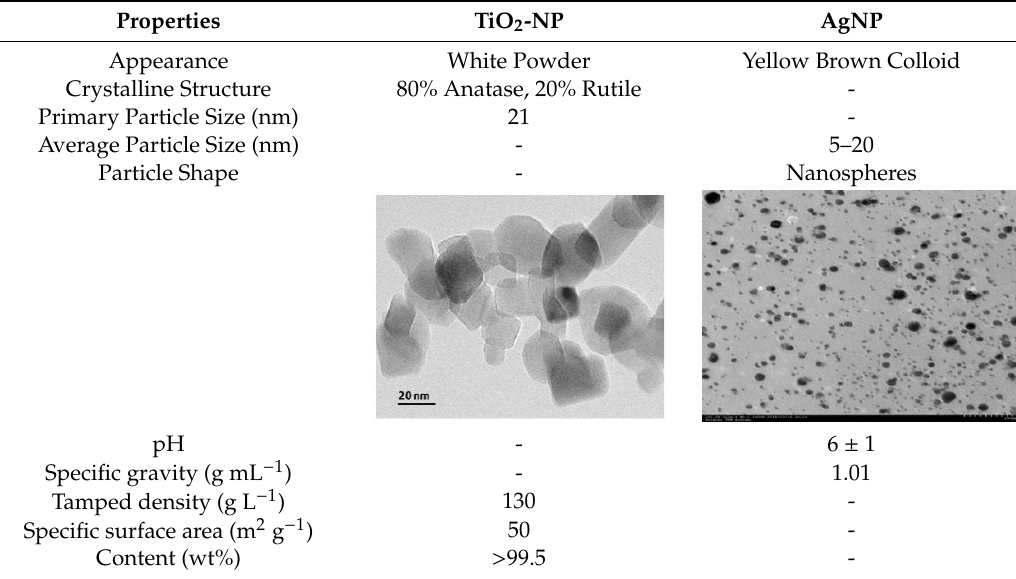
Table 2. Properties of titanium dioxide and silver nanoparticles (TiO 2 -NP and AgNP).